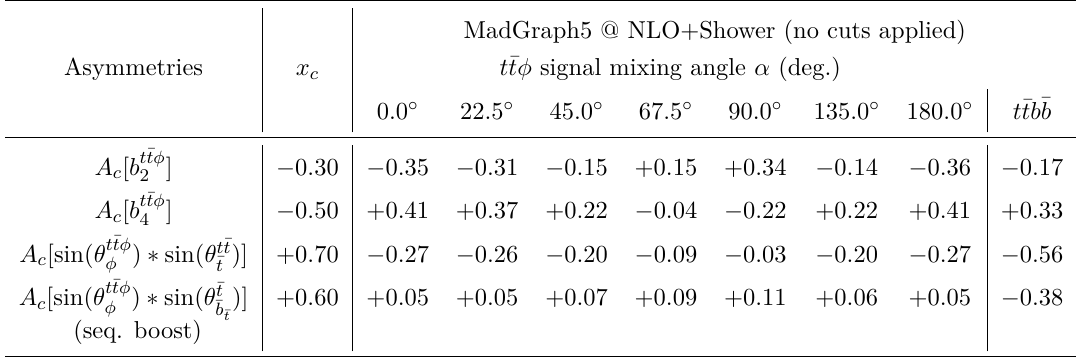
Table 1 . Asymmetries for the t ¯ tφ signal as a function of the mixing angle α , as well as for the dominant background t ¯ tb ¯ b at NLO+Shower (without any cuts), are shown for several observables. Significant differences between the asymmetries for the pure scalar ( α = 0 . 0 ◦ ) and pseudo-scalar ( α = 90 . 0 ◦ ) cases are observed for several